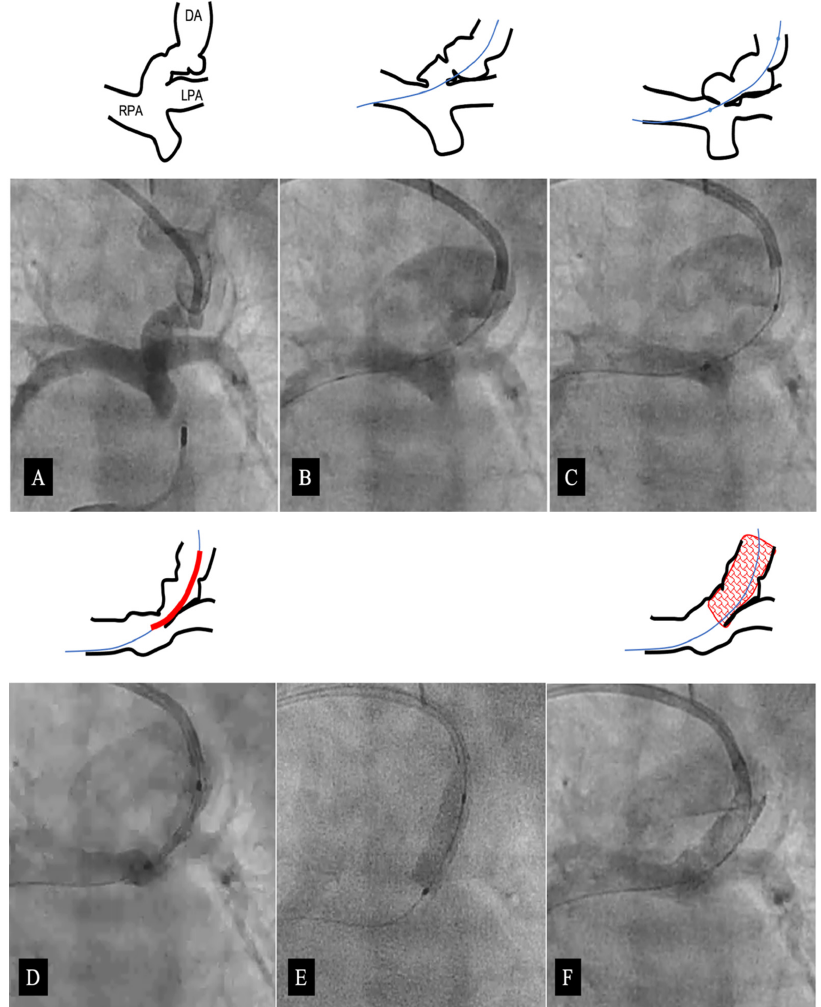
Figure 4. Stenting of a tortuous vertical ductus arteriosus (DA). ( A ) Selective arch aortogram near origin of the DA. ( B ) Repeated selective angiogram after placing the guidewire in the right PA demonstrated stretching of the DA. ( C ) Length interrogation was performed with markers of the coronary balloon catheter (without inflation). ( D ) Introducing the stent with the same length of the previous balloon catheter. ( E ) Inflation of the stent at its nominal pressure. ( F ) Final angiogram showed satisfactory stent position with unobstructed flow to both PAs. RPA: Right pulmonary artery, LPA: Left pulmonary artery.